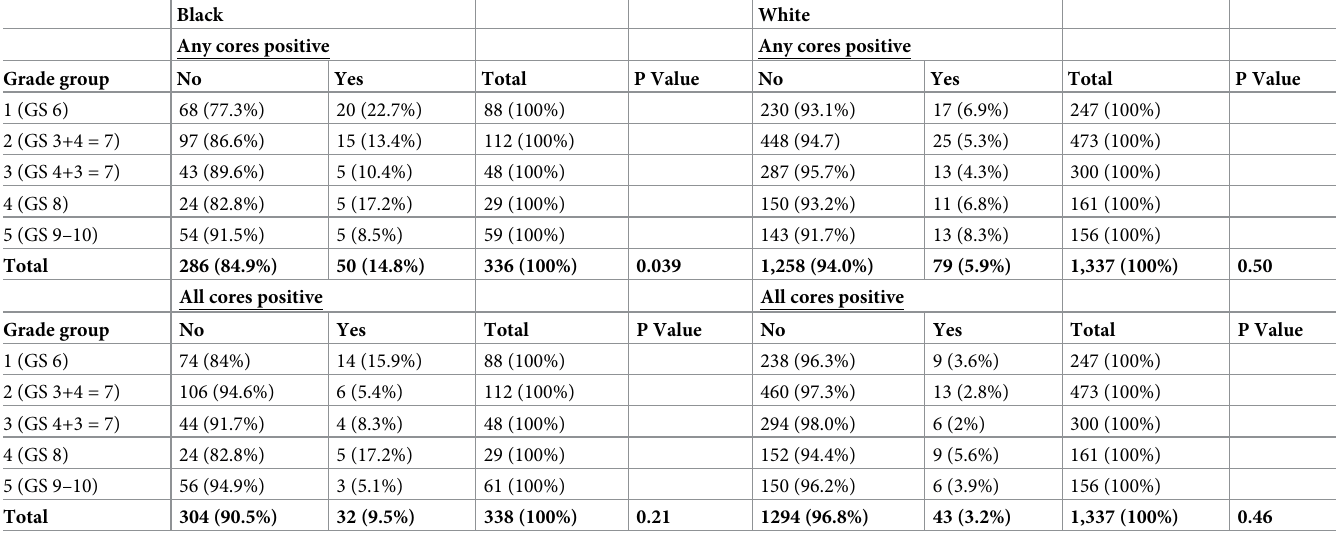
Table 3. GSTP1 protein staining by Gleason grade groups in Black and White patients.